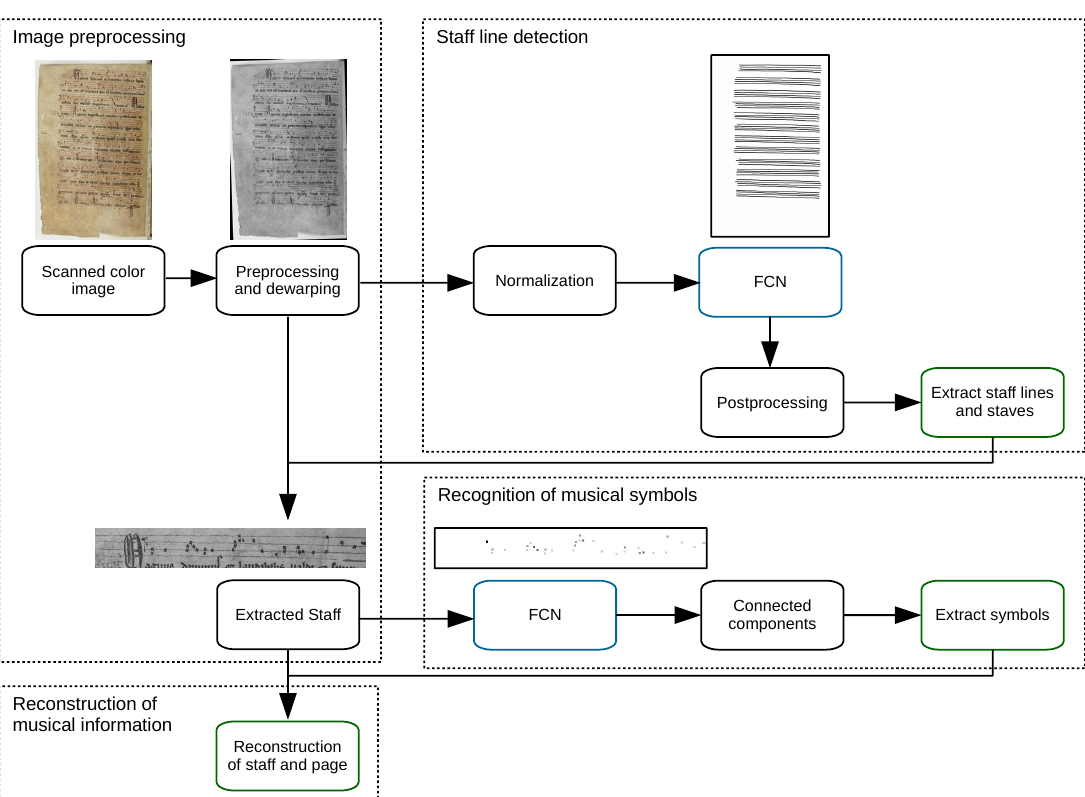
Figure 3. Schematic view of the workflow of the staff line and symbol detection. The small images show the original image and the input and output of the respective Fully Convolutional Network